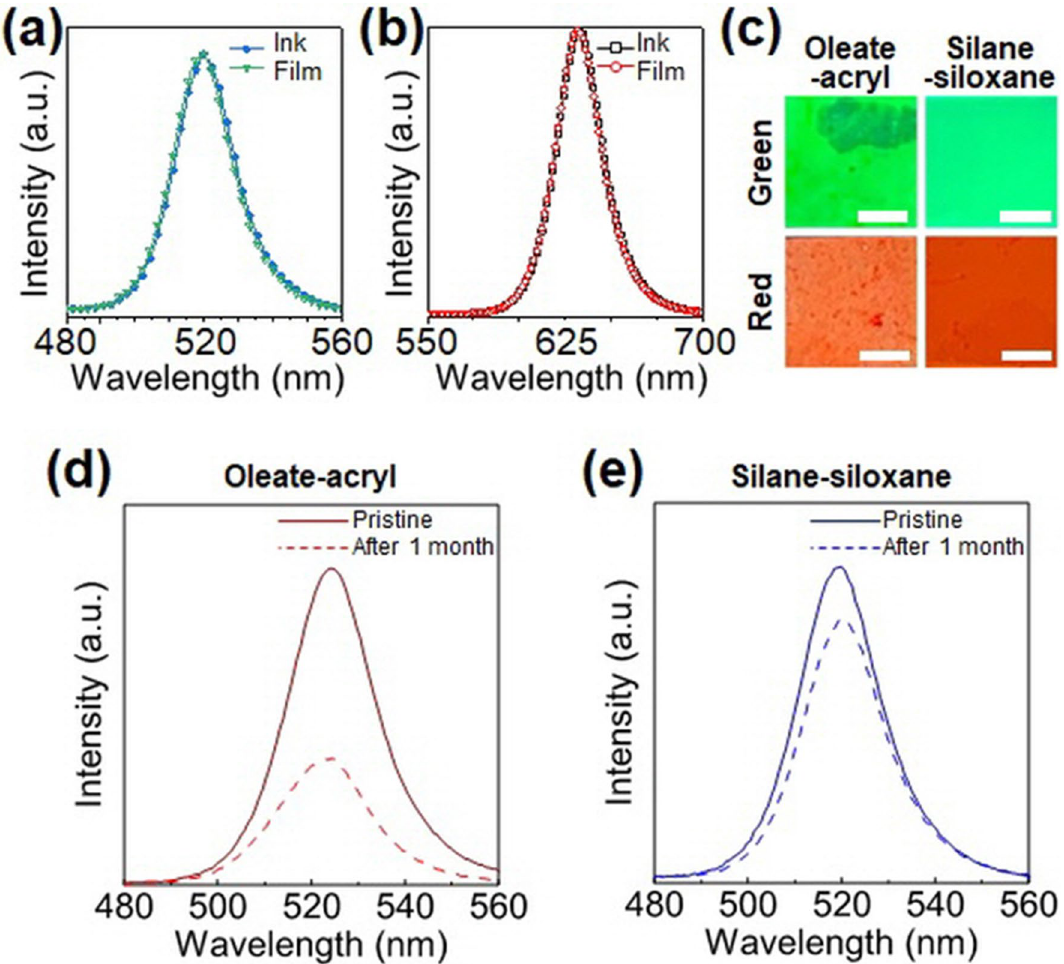
Figure 3. Photoluminescence (PL) spectra of ( a ) green perovskite quantum dots (PQDs) and ( b ) red PQDs in solution with silane and in film form after UV curing. ( c ) Optical microscope images of oleate-capped PQD/ acrylate and silane-capped PQD/siloxane composites (scale bar: 500 μm). PL spectra of ( d ) oleate-capped PQD/ acrylate composite and ( e ) silane-capped PQD/siloxane composite. The dash line indicates the PL spectra after one month of storage under ambient